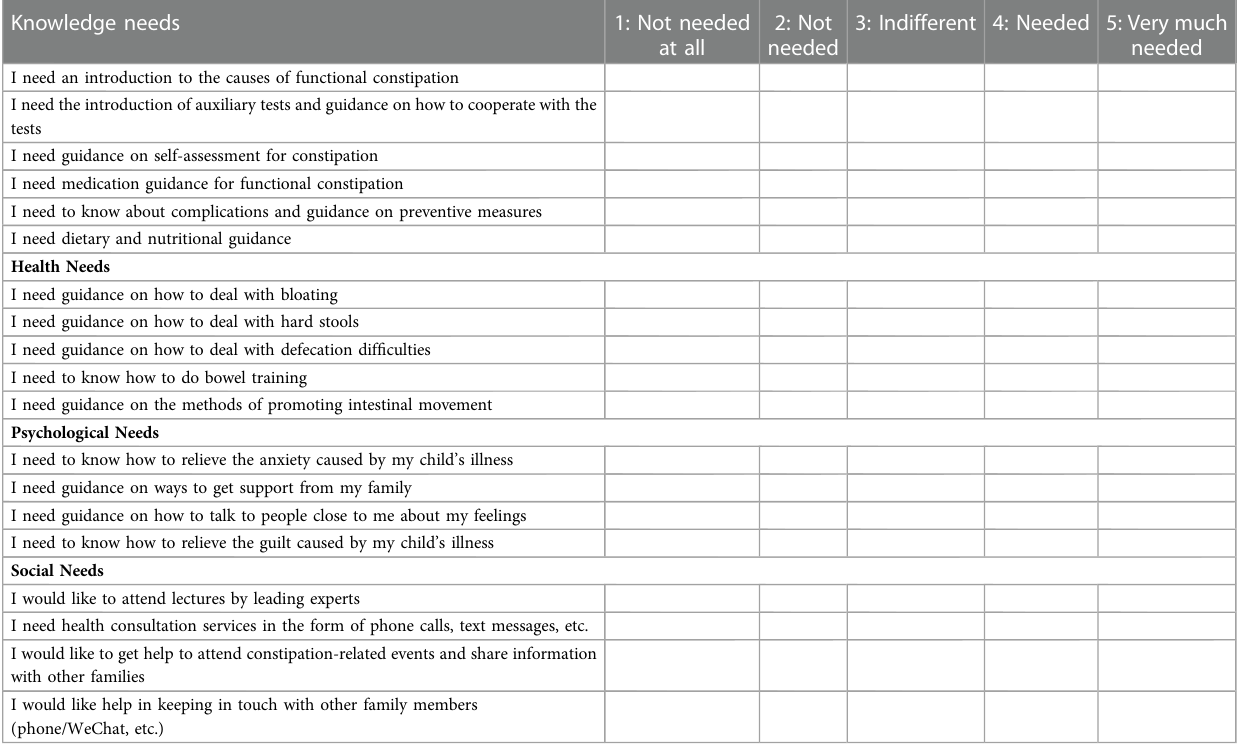
TABLE 1 Caregiving needs questionnaire of parents of FC